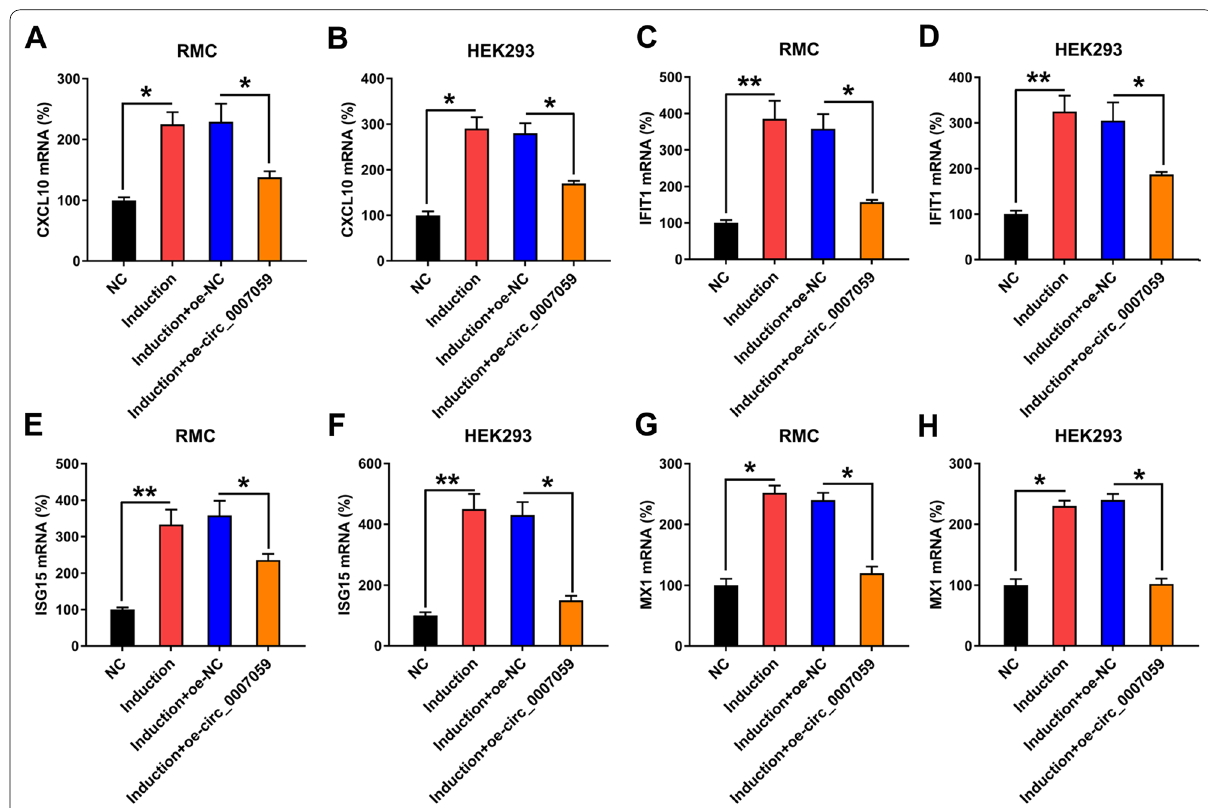
Fig. 4 Effect of circ_0007959 overexpression on the apoptosis of IFN‑induced genes in RMCs and HEK293 cells. RMC and HEK293 cells were transfected with a circ_0007059‑overexpressing vector or NC vector for 24 h, followed by treatment with 1,000 units/mL IFN for 24 h. RT‑qPCR was used to determine the expression of mRNA for A , B CXCL10, C , D IFIT1, E , F ISG15, and G , H MX1 in RMCs and HEK293 cells (biological replicates, 1; technical replicates, 4; repeat time, 3). Values are expressed as the mean SEM for technical replicates. *P < 0.05, **P < 0.01 vs. the indicated group ±